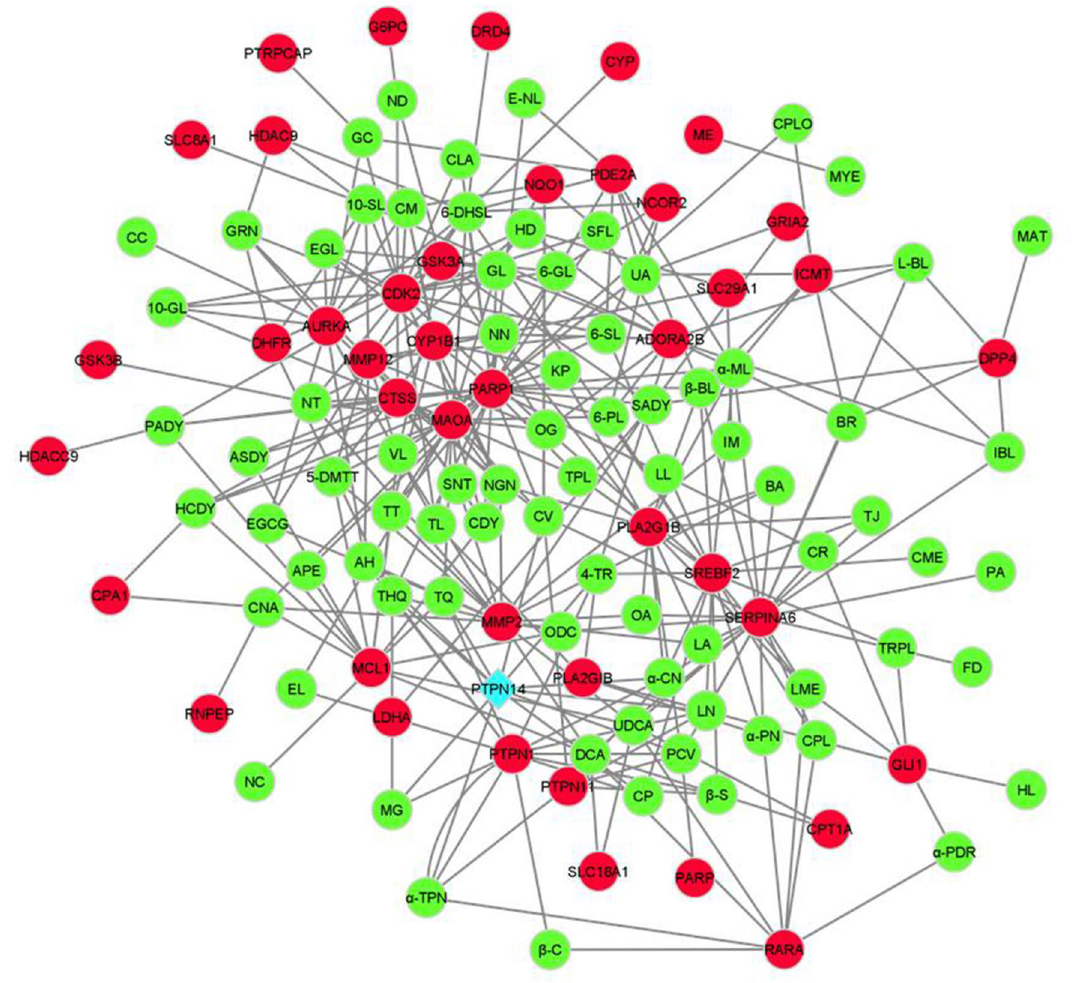
Figure 4. Visualization of CTN. Red color represents the immune responsive genes and green color represents the compound and blue color represents the tumor suppressor gene targeted by